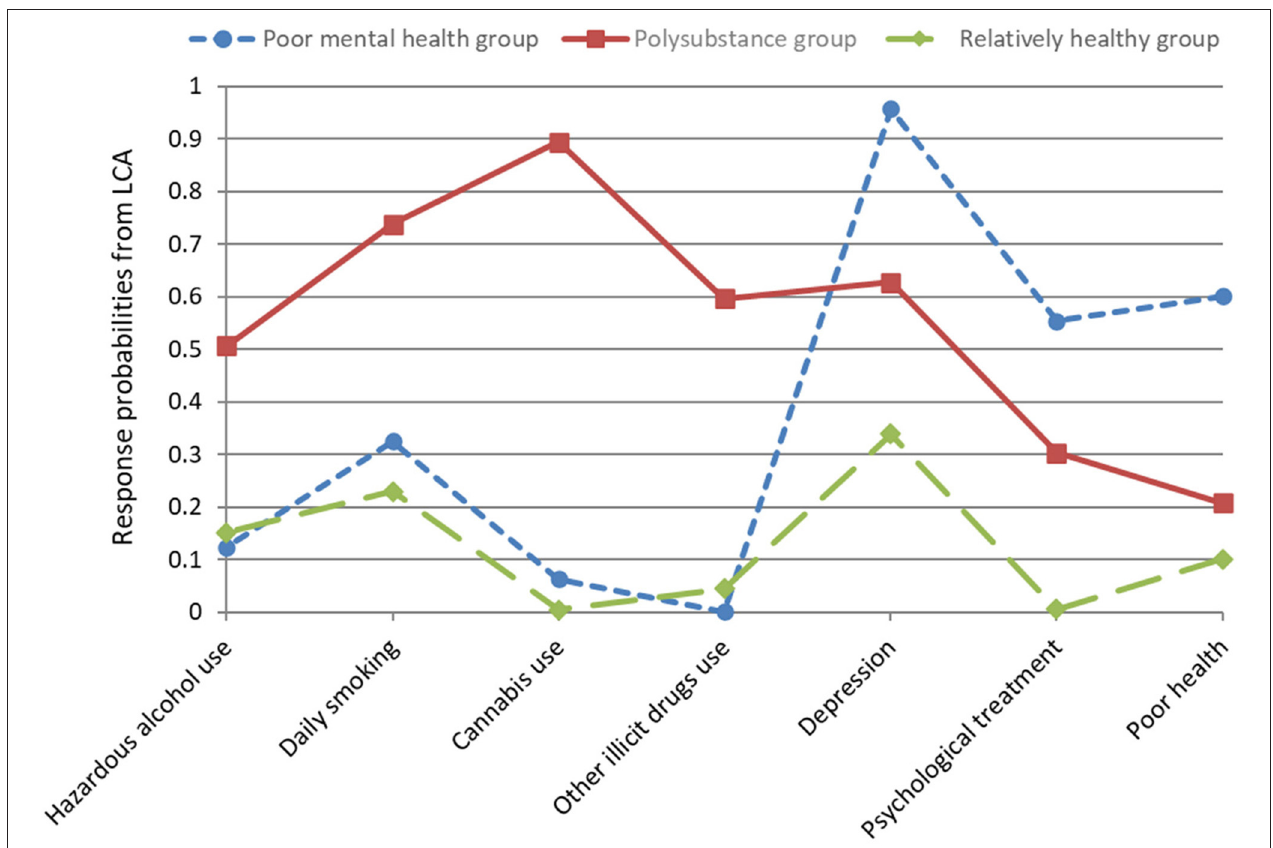
FIGURE 1 | Estimated class-specific response probabilities for seven pOUD risk factors. A high score indicates a high probability of a particular risk factor.